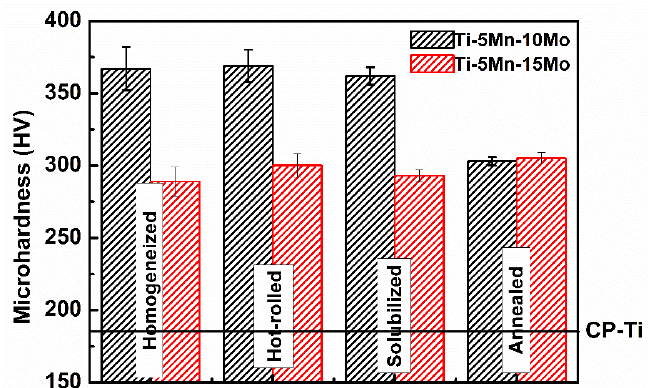
Figure 5. Microhardness for Ti-5Mn-10Mo and Ti-5Mn-15Mo alloys under all processing conditions compared to CP-Ti.